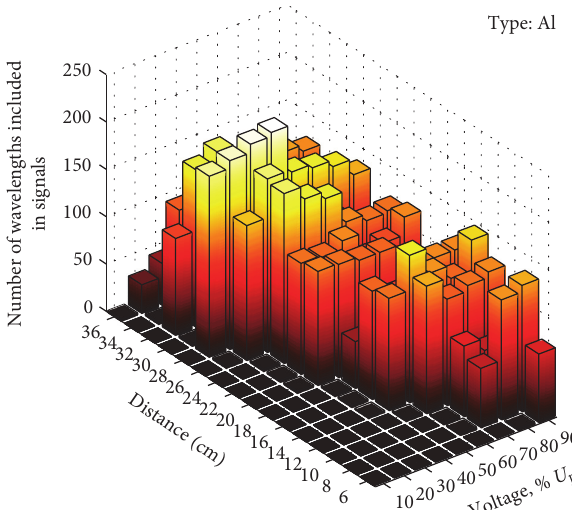
Figure 11: Dependency of voltage and distance on the number of wavelength components for the AlSi5